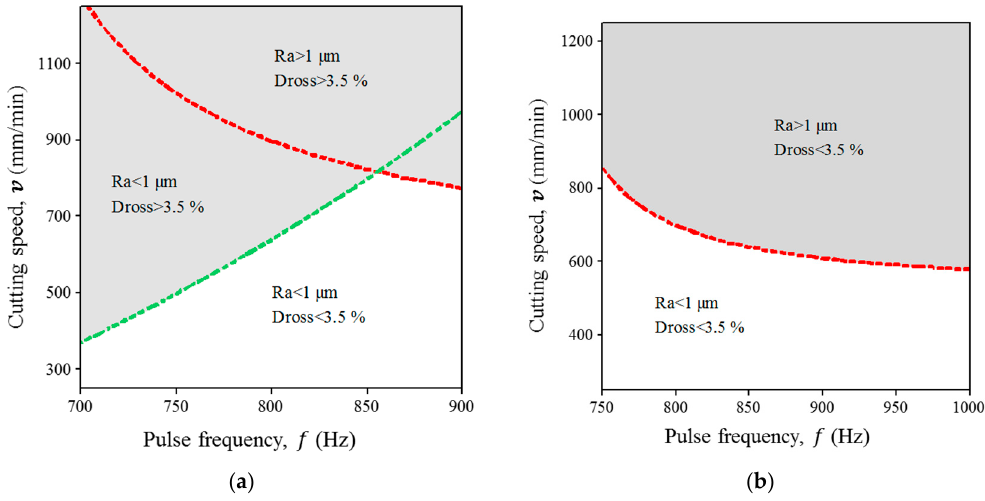
Figure 4. Influence of pulse frequency and cutting speed on surface roughness and back wall dross. ( a ) Miniature Tube A: Annealed and 110 μ m thickness (fixed parameters: pulse width, 0.18 ms; peak power, 160 W; gas pressure, 10.34 bar). ( b ) Miniature tube B: Hard drawn and 160 μ m thickness (fixed parameters: pulse width, 0.19 ms; peak power, 170 W; gas pressure, 12.06 bar).